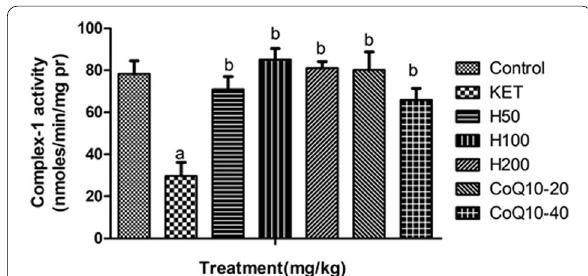
Fig. 12 Effect of hesperidin and Coenzyme Q10 on complex I enzyme activity in the hippocampus region of the brain. Data were analyzed by one-way ANOVA followed by Tukey’s post hoc analysis. All values were expressed as Mean SEM. a p < 0.05 as compared ± to naive, b p < 0.05 as compared to ketamine. KET, Ketamine; H,